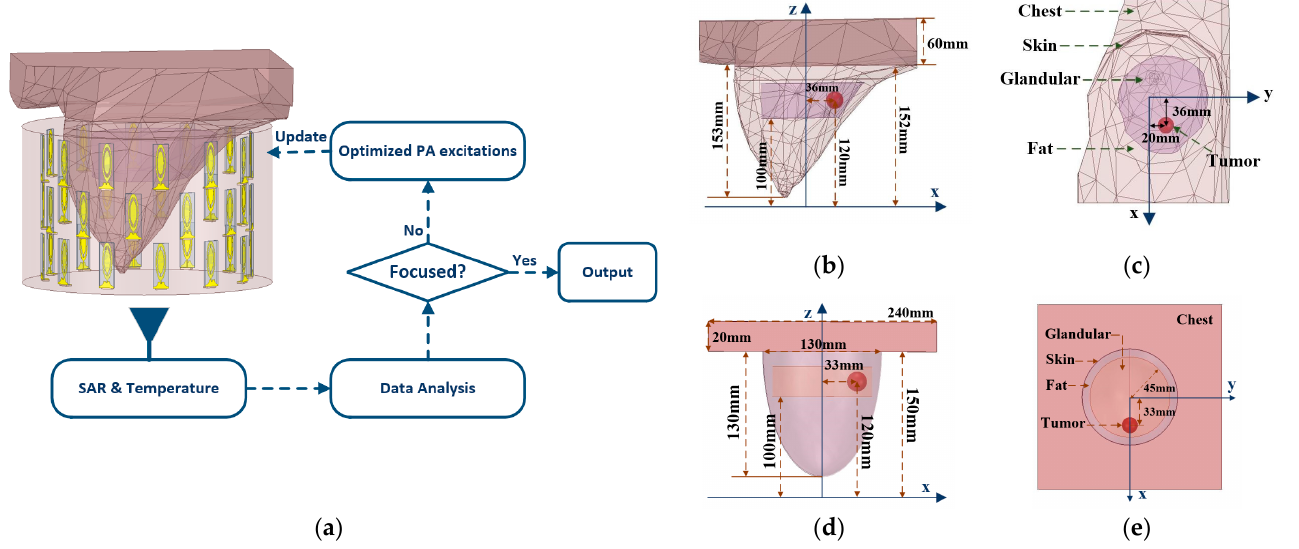
Figure 1. The process of optimizing dual-resonant phased array applicator in HTP and two breast models. ( a ) Flowchart of HTP employed in this work; ( b ) Side view of a heterogeneous breast model; ( c ) Top view of a heterogenous breast model; ( d ) Side view of a general breast model; ( e ) Top view of a general breast model.